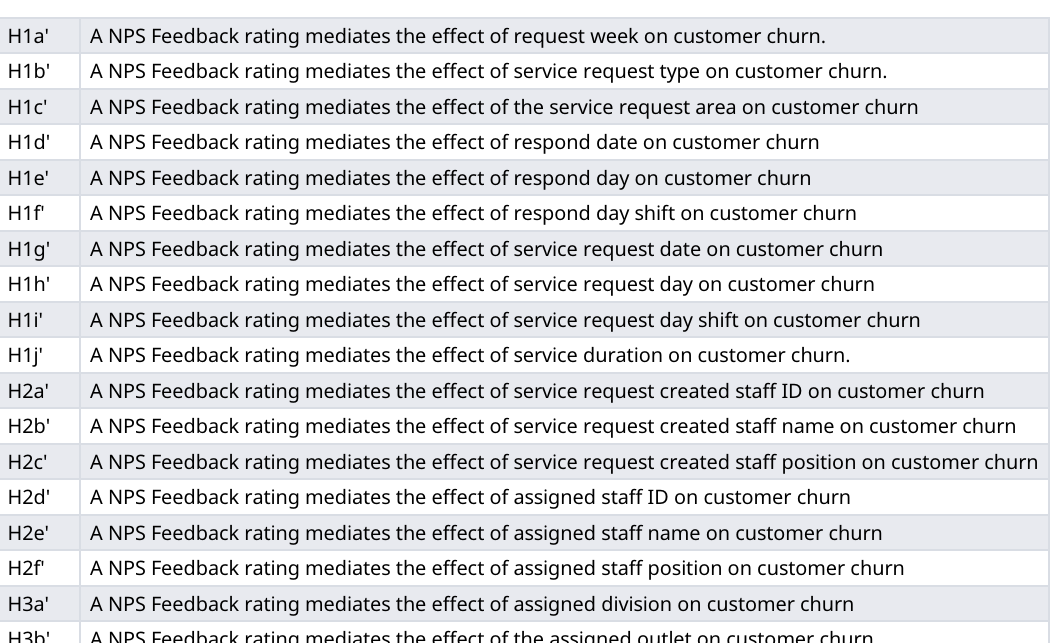
Table 9. Mediation effects on NPS feedback.